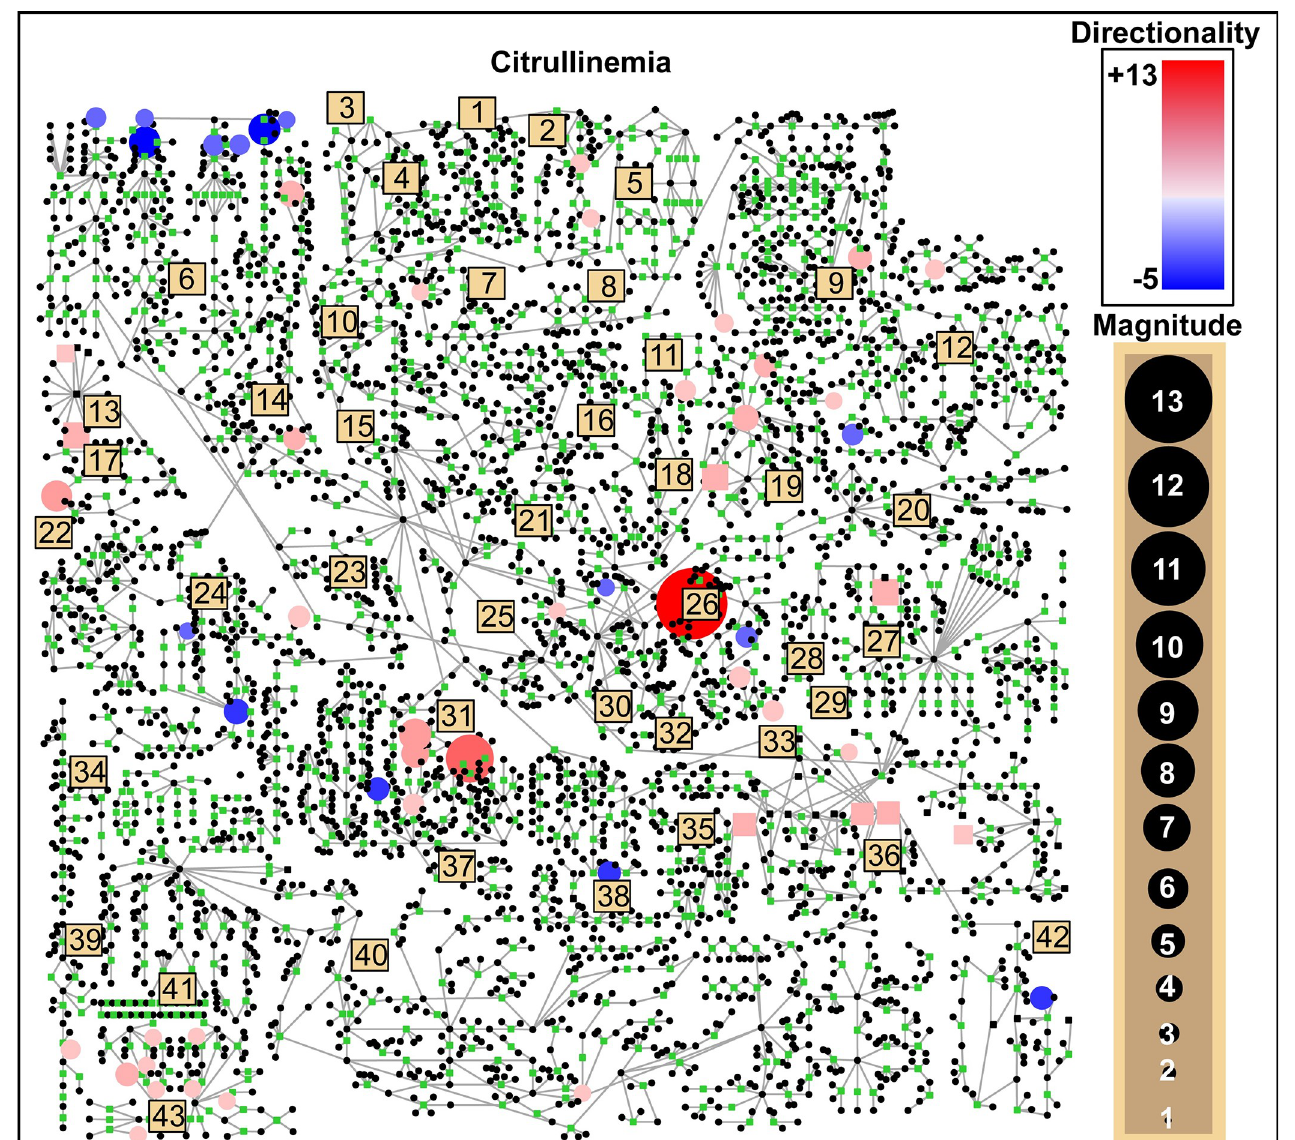
Fig 1. A comprehensive human metabolic pathway map with patient-specific metabolic perturbations overlaid. Representative data are shown for plasma citrullinemia patient IEM_1023. Circular nodes are metabolites and are colored red if they were perturbed upwards, and blue if perturbed downwards. The diameter of the node reflects the magnitude of the perturbation. Beige squares refer to particular sub-pathways (see S1 Table ) which are aligned according to a coordinate space curated by Metabolon (MetaboLync Pathway Visualizations software, version 1.1.2, Copyright 2014 Metabolon, Inc., Research Triangle Park, NC,